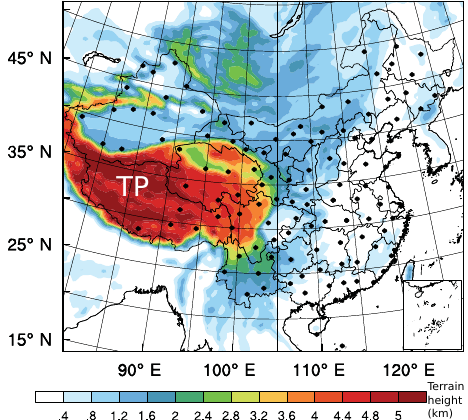
Figure 1. Spatial distribution of CMA sounding sites (black dots), overlaid over the terrain height (color shaded) of China. The white “TP” indicates the location of the Tibetan Plateau. This figure was plotted using the Lambert conformal conic